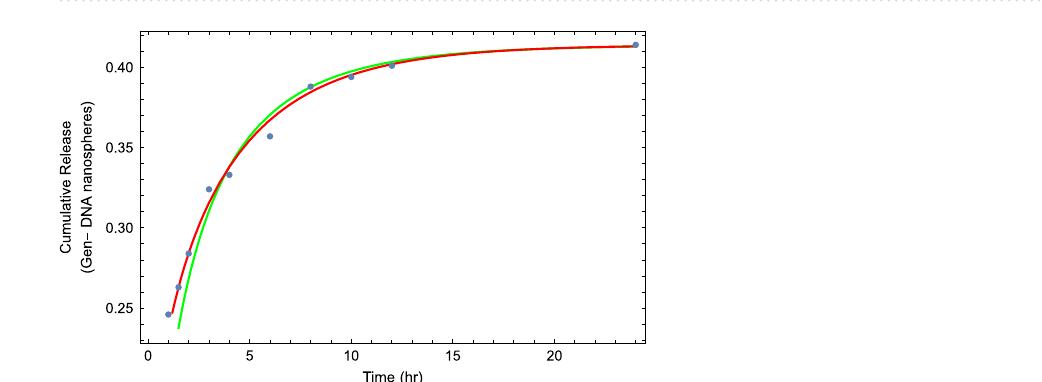
Figure 11. Mean square displacement Eq. 15 for different values of ( a ) time-fractional order α and ( b ) tempered parameter in case of R = 0 and κ = 0.5 .